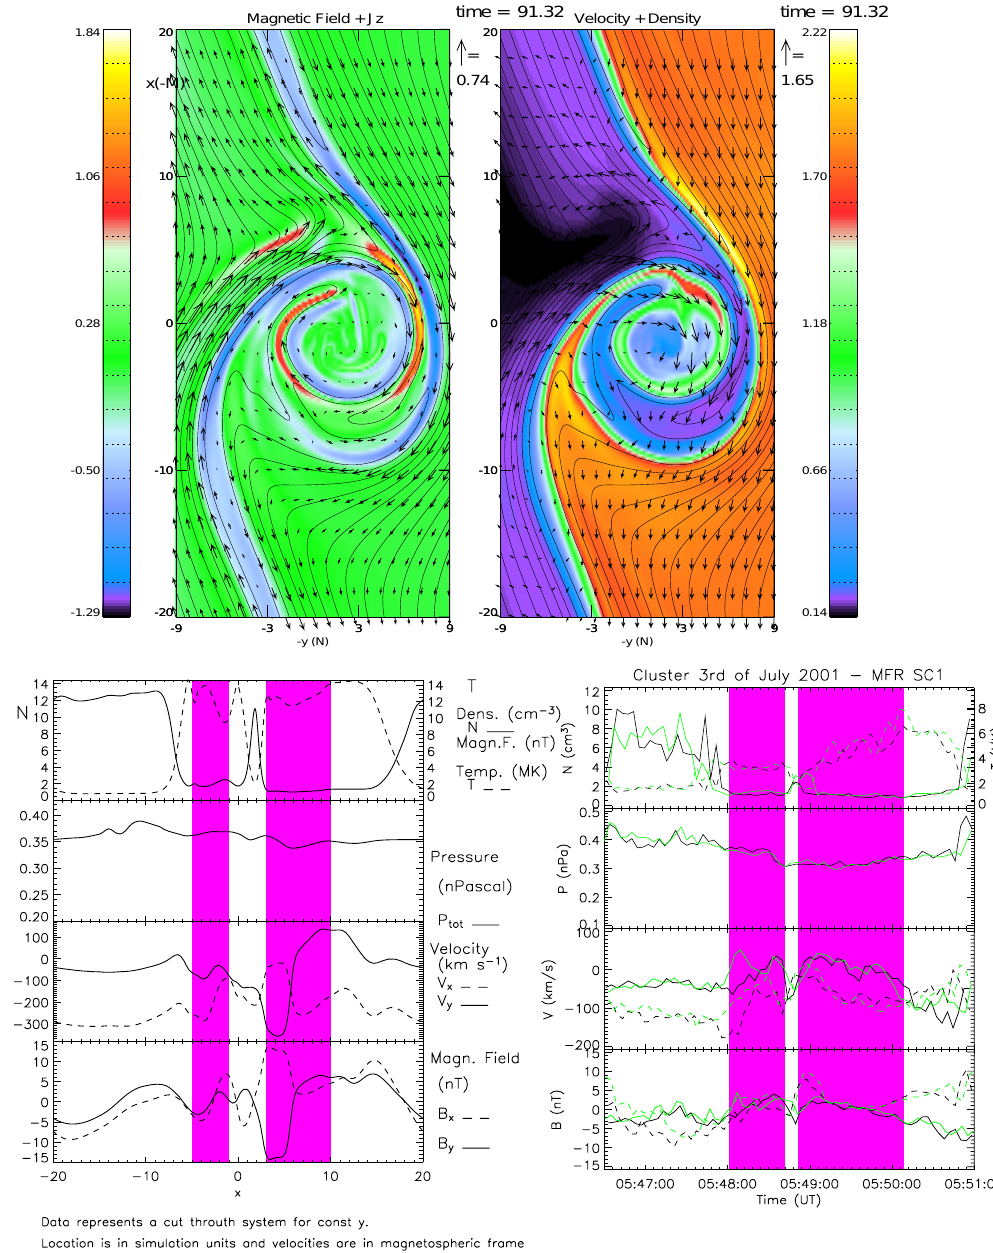
Fig. 11. MHD simulation result of the KH wave at t =410s. The magnetic field and j z are plotted on the top left panel and velocity and density at top right panel. The black lines are magnetic field lines. The bottom left panel has a cut through at y =2, corresponding to a measurements of a virtual spacecraft as the wave passes through it. The bottom right panel has Cluster sc1 and sc3 data between 05:46:30–05:51 UT in boundary normal coordinates of sc1. The data panels show from top to bottom plasma density and temperature, total pressure, normal (solid line) and tangential (dashed) component of plasma velocity, normal and tangential component of the magnetic field. The intervals satisfying reconnection criteria are marked with vertical magenta